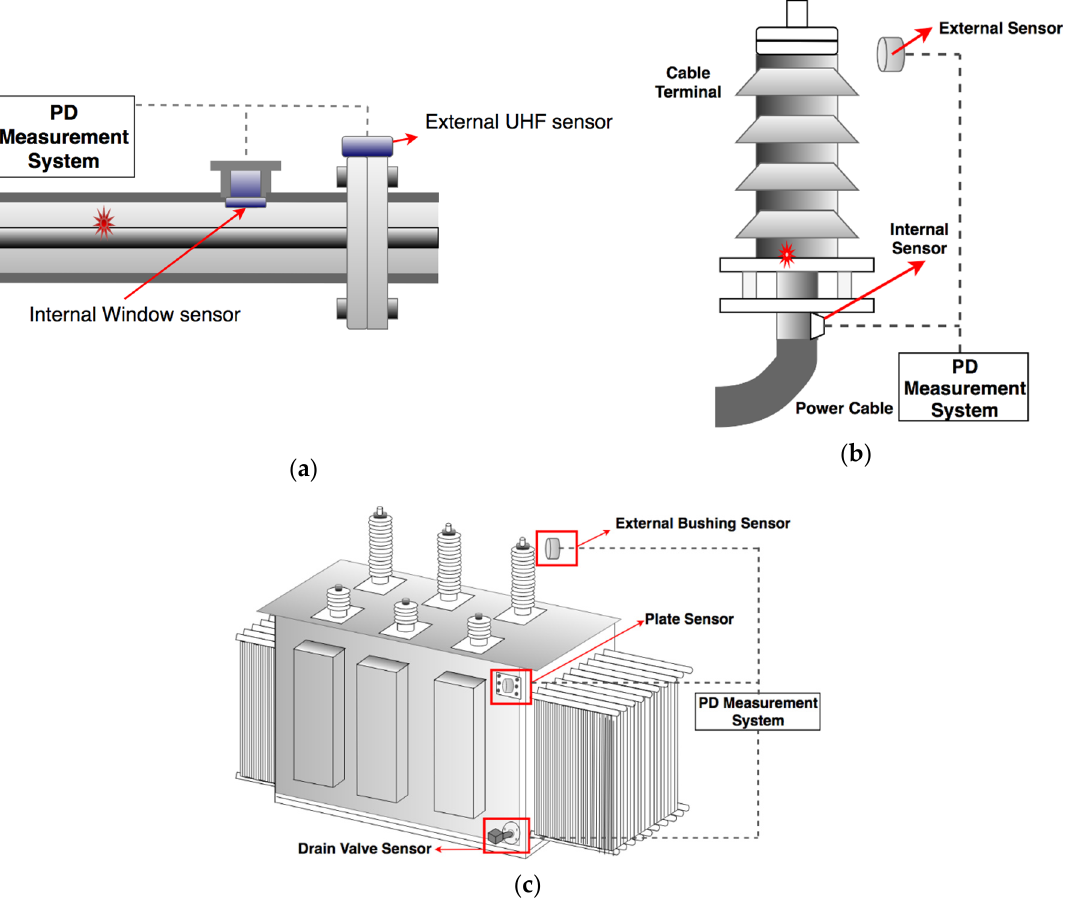
Figure 2. Installing locations for UHF sensors: ( a ) GIS; ( b ) cable terminal; ( c ) power transformer.